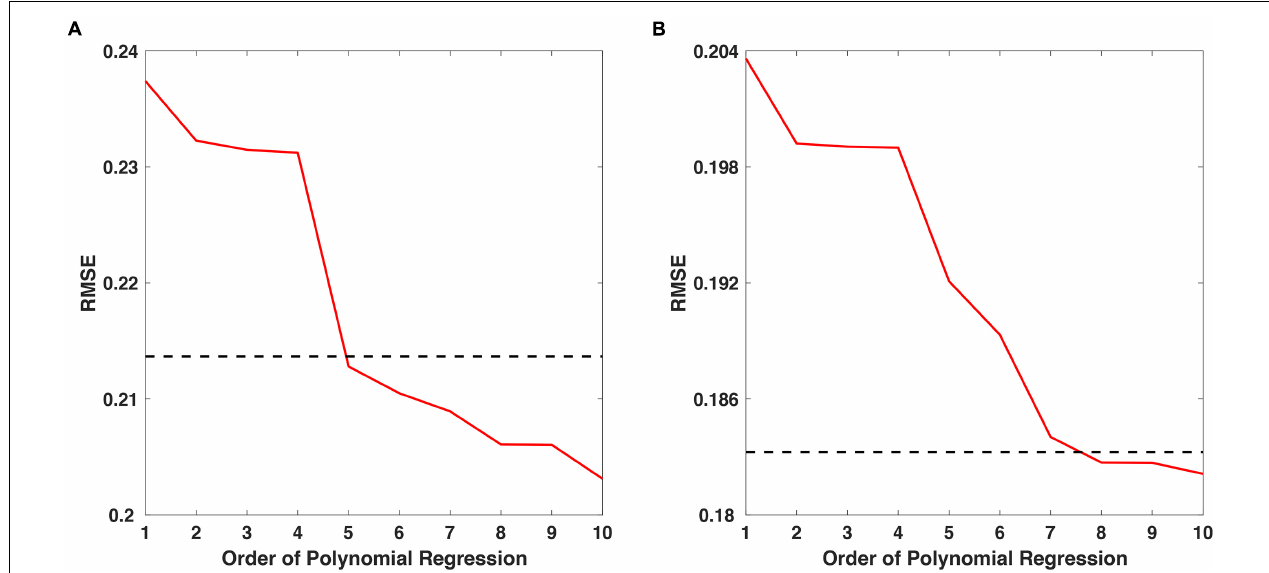
FIGURE 2 | The RMSE changes as a function of polynomial order for approximating SSVEP responses for (A) “fear” and (B) “nervous” videos. The dashed line indicates 0.9 α , where α is the RMSE of the 1st-order polynomial regression.